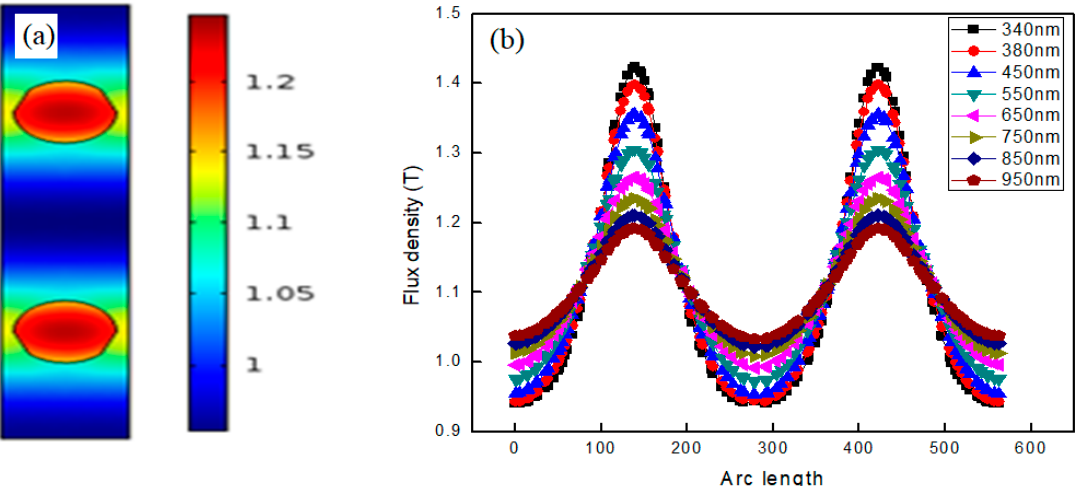
Figure 3. ( a ) Plasmon formation at interfaces of two GaN Nanowires placed at distance of 284 nm by shining light of 340 nm. The color bar represents flux density in region of plasmons. ( b ) Flux density versus arc length showing the existence of plasmons by variation of flux density in the region where plasmons formed at different wavelengths when two nanowires are decoupled and placed at distance of 284 nm.